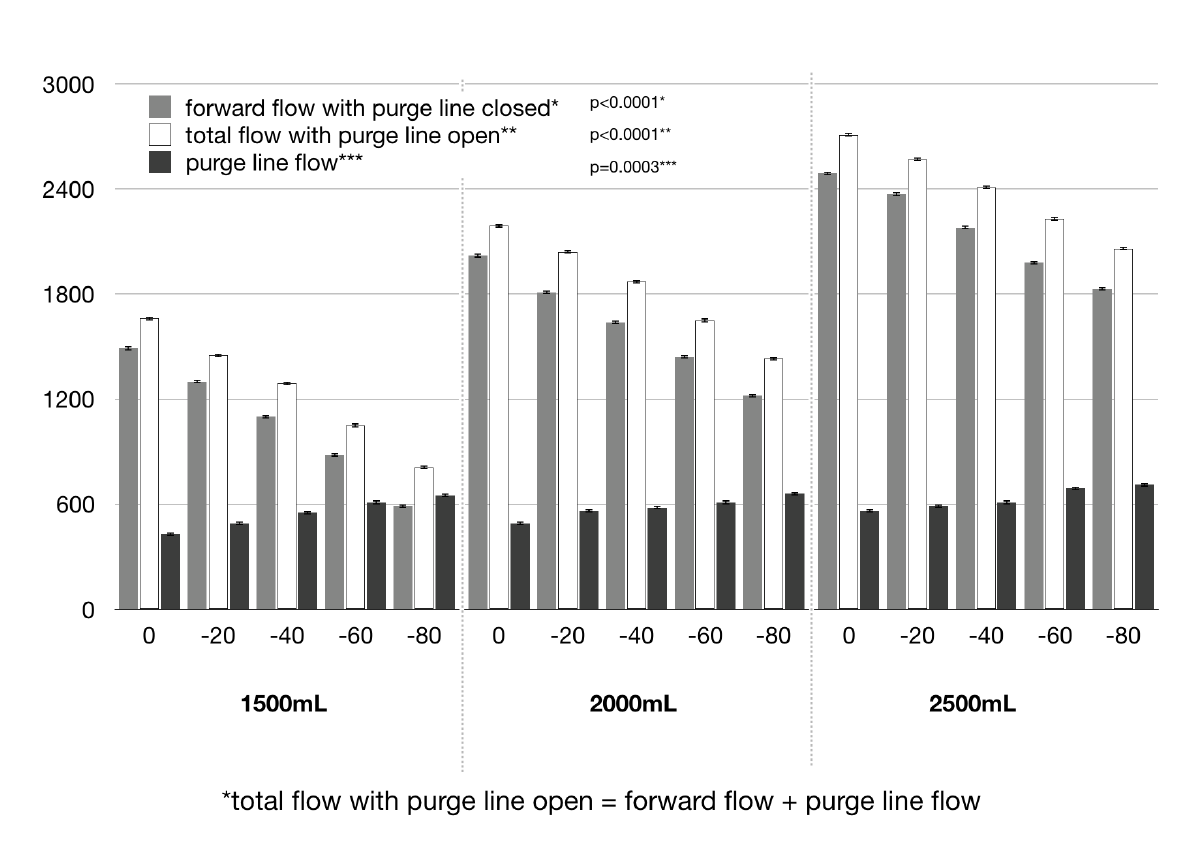
Fig. 2 – The total (post-arterial filter flow + deviated flow through the purge line) forward flow increases when purge line is open as a compensation to the stealing flow in this